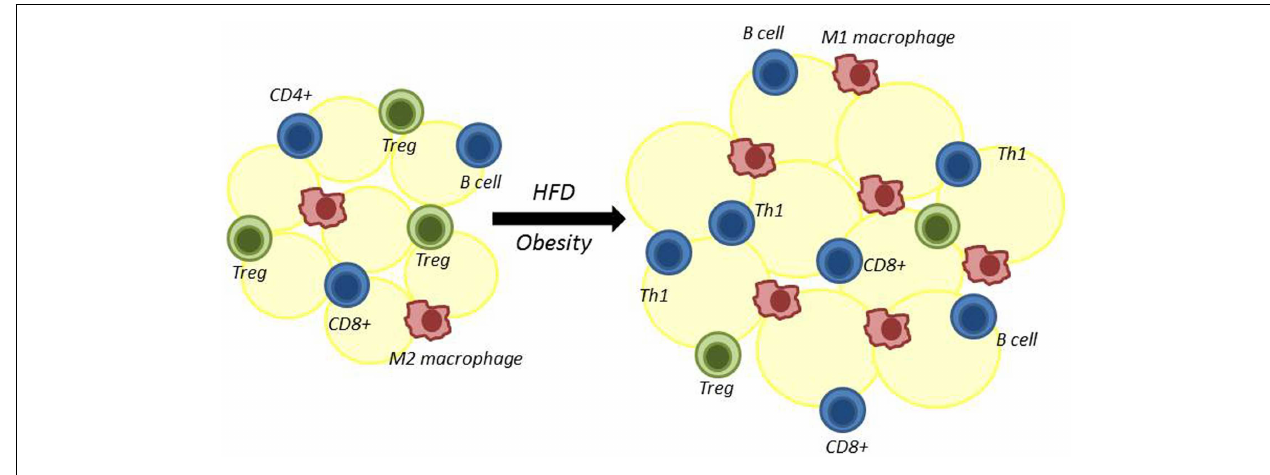
increase in adipose-resident inflammatory macrophages (classically activated M1 macrophages), CD4 + Th1 cells, CD8 + T cells, and B cells. The role of CD4 + Th2 andTh17 cells in adipose tissue in obesity is less